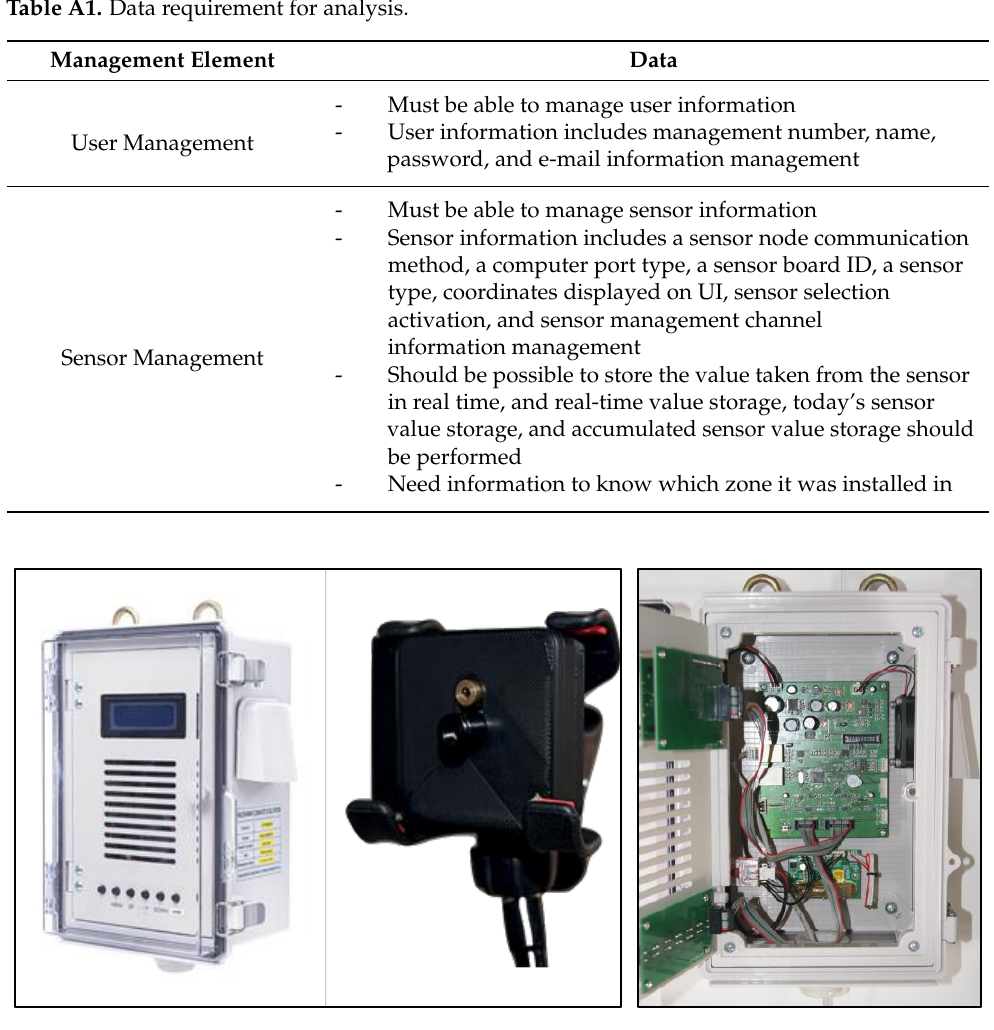
Figure A2. The main software user interface.